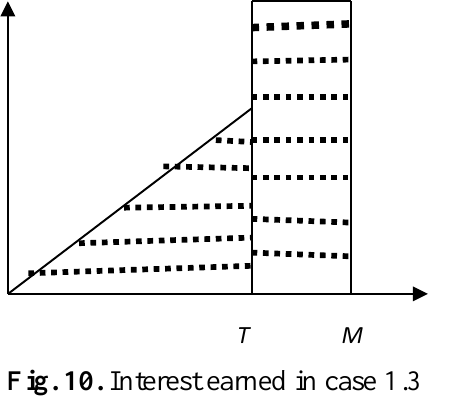
Fig. 10. Interest earned in case